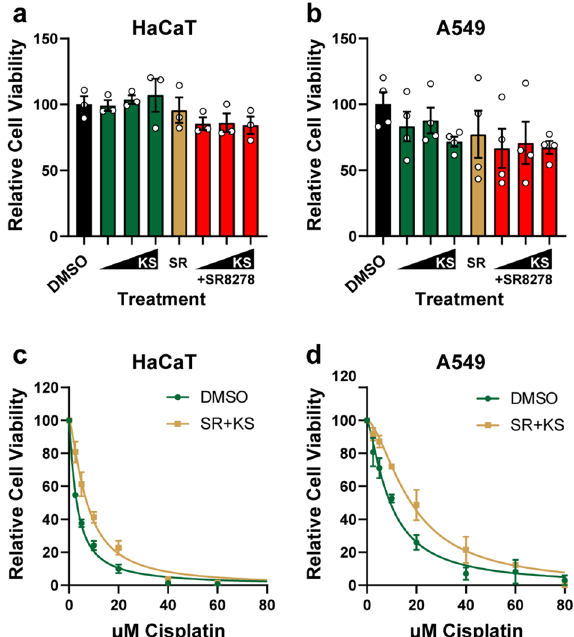
Figure 2. KS15 and SR8278 protect HaCaT and A549 cells against cisplatin treatment. (a) MTT assays were performed in HaCaT cells treated with KS15 and SR8278 (average and SEM, n = 3). (b) HaCaT cells were treated with DMSO or a combination of 50 µM KS15 and 10 µM SR8278 along with the indicated concentrations of cisplatin. MTT assays were performed two days later (average and SEM, n = 3). (c) A549 cells were treated as in (a), and MTT assays were performed (average and SEM, n = 4). (d) MTT assays were performed in A549 cells were treated with cisplatin and DMSO or the combination of 50 µM K15 and 10 µM SR8278 (average and SEM, n =